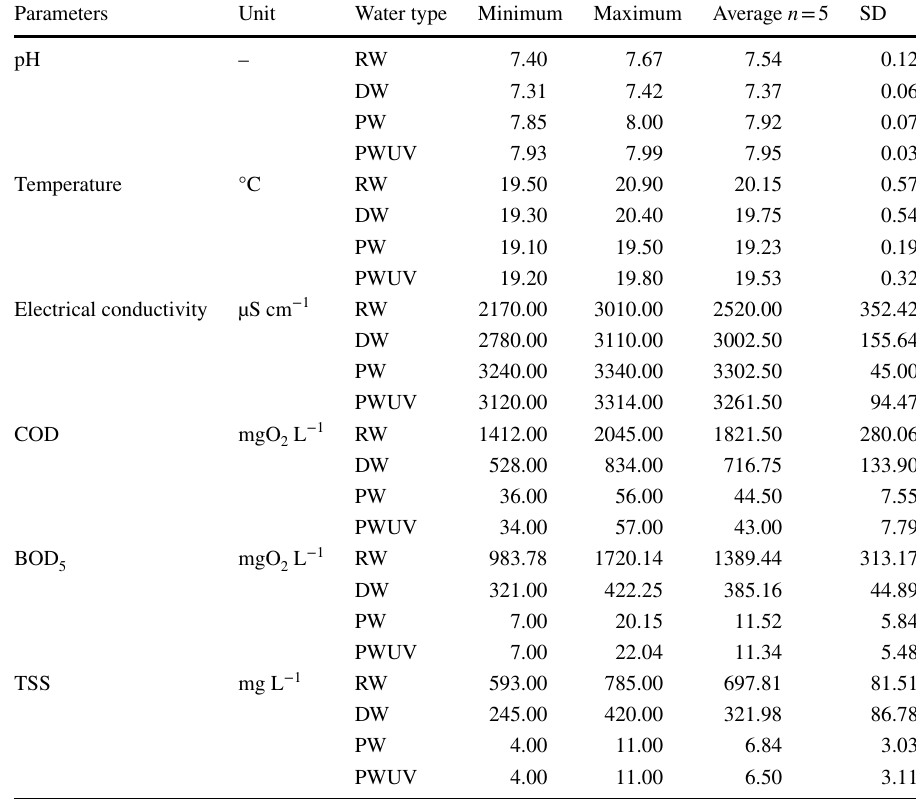
Table 2 The average values of physicochemical parameters of Agadir wastewater, from February to June 2015